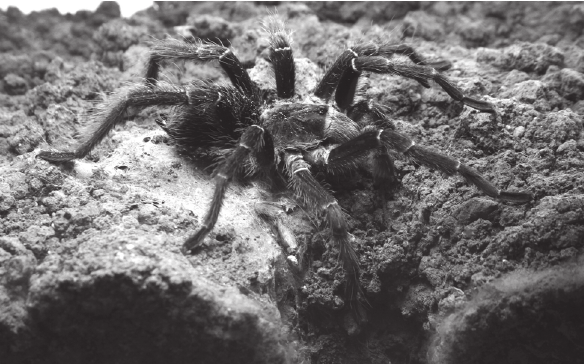
Figure 1. Male of E. weijenberghi courting at the entrance of the female’s burrow. Note the dense whitish silk mat covering the soil.